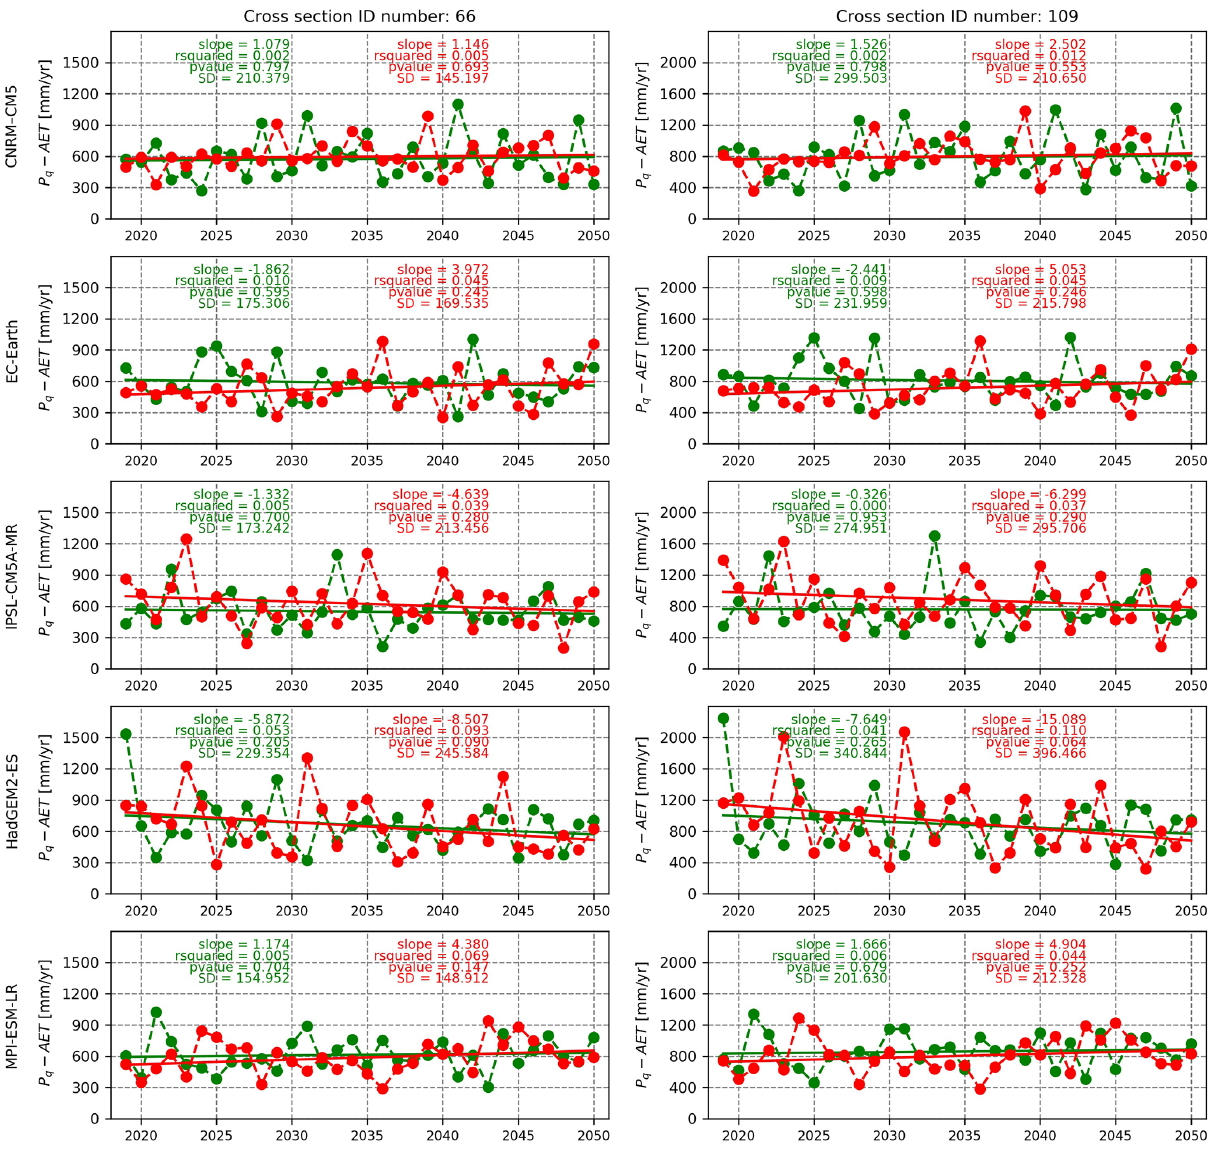
Figure 7. Yearly drainage projections (RCP4.5 scenario in green and RCP8.5 scenario in red) for two different cross-sections (Dora Riparia in Torino, cross-section 66, and Orco in San Benigno, cross-section 109) of the studied area. Each row corresponds to the results obtained with one GCM driving the RCA4 RCM. The slope of the regression line, the coefficient of determination R 2 , the p value and the standard deviation evaluated for the detrended time series are also